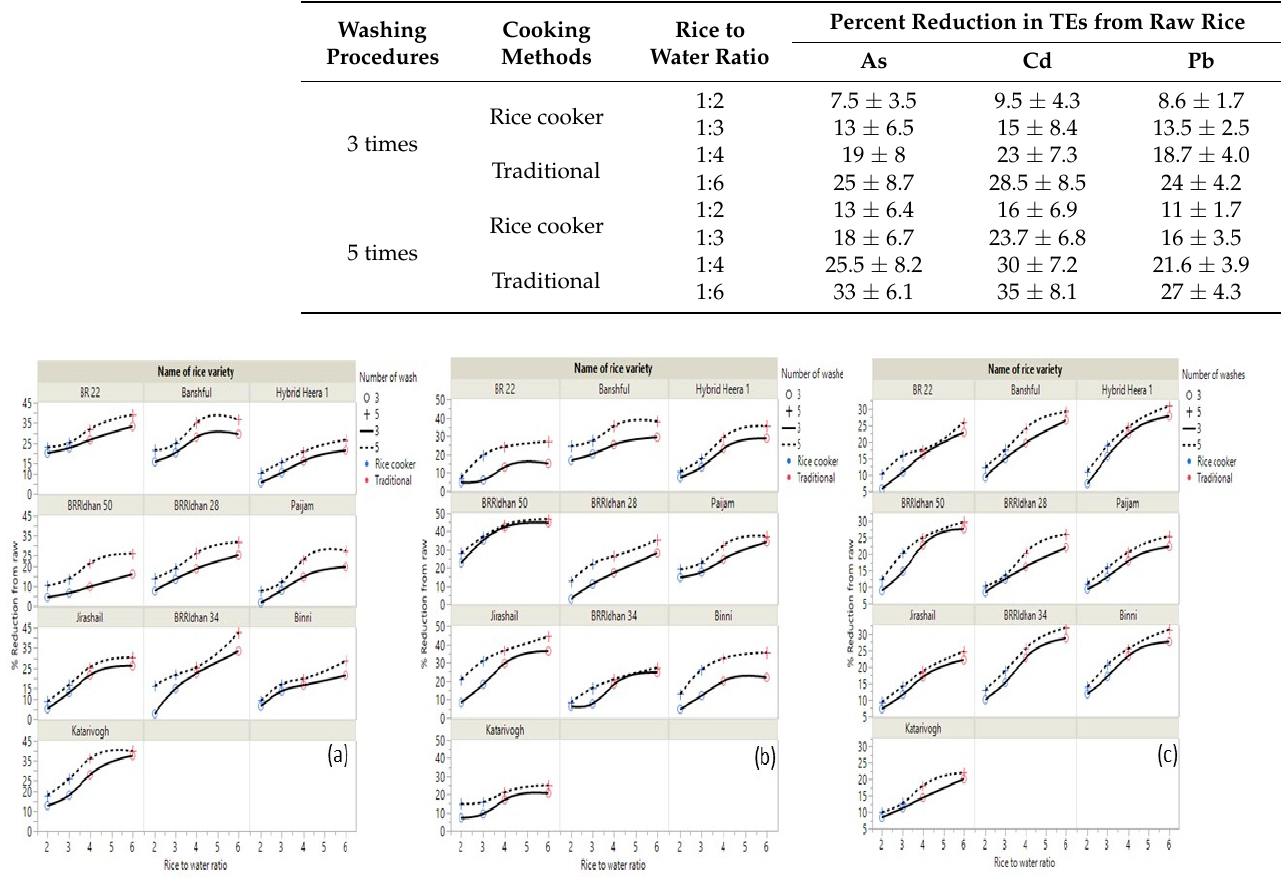
Table 3. Average reduction (%) in TEs from different brands of rice in different cooking procedures.